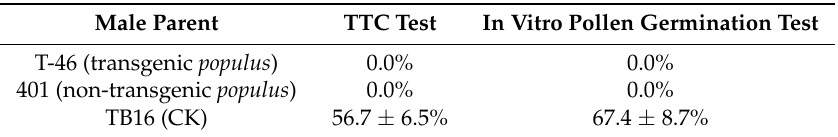
Table 2. Pollen viability (%) of three male parents at blooming day by the TTC and in vitro pollen germination tests (6 h).